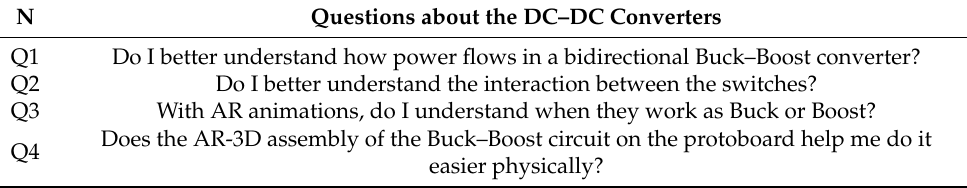
Table 5. Survey for the use of the AR DC–DC converters.